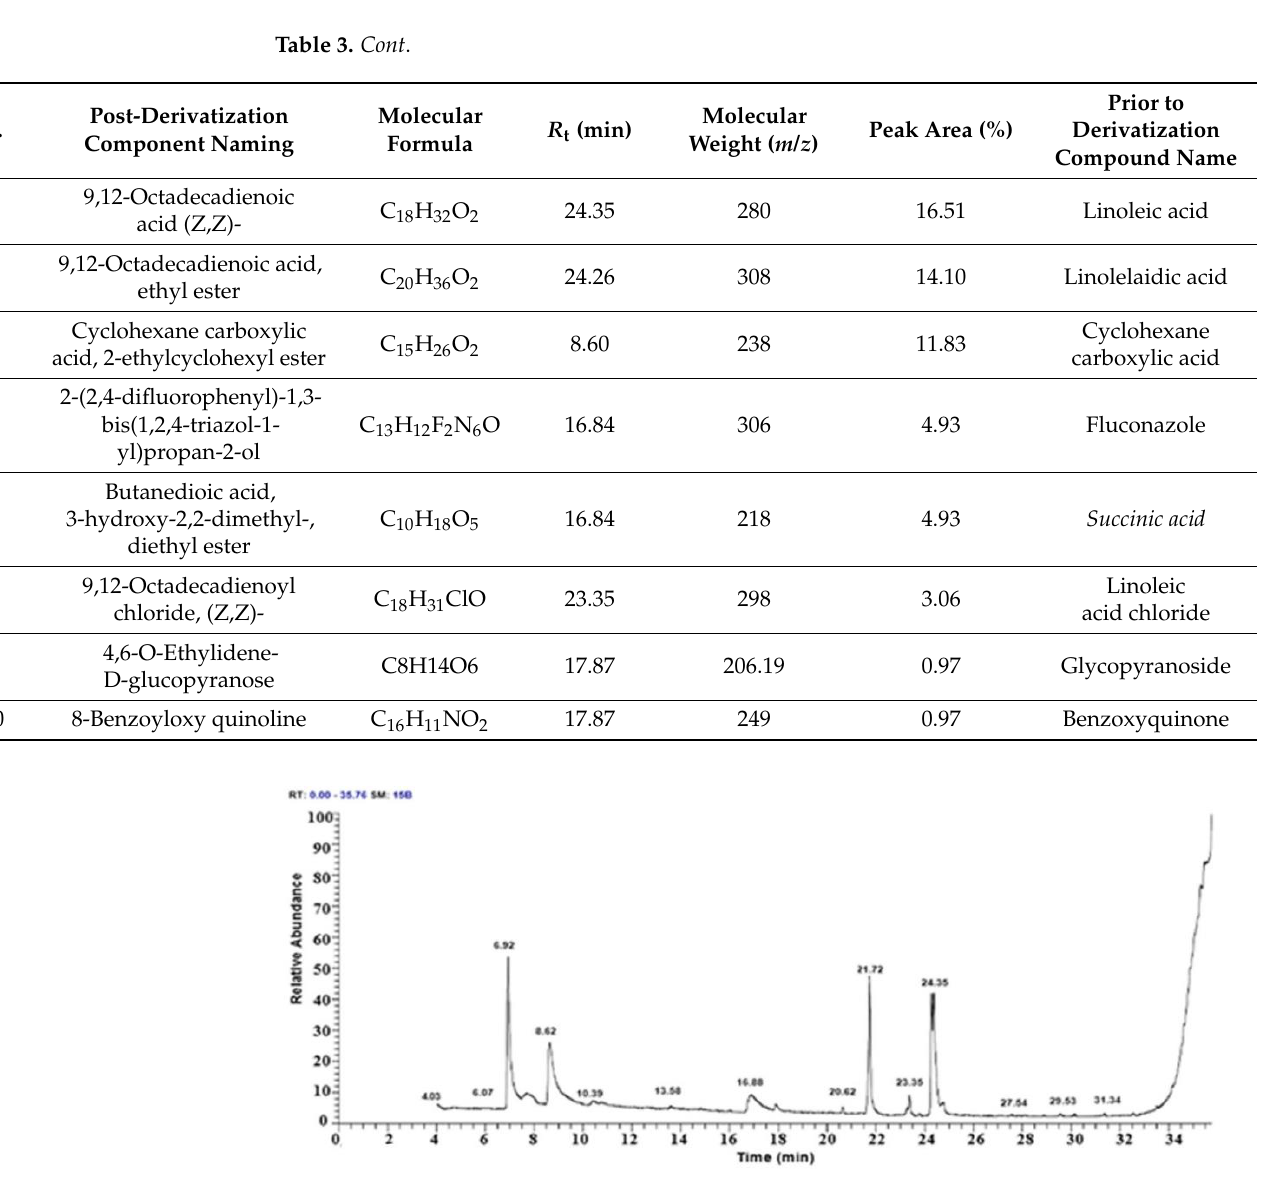
Table 3. GC-MS-MS profile of Roselle ethyl extract.